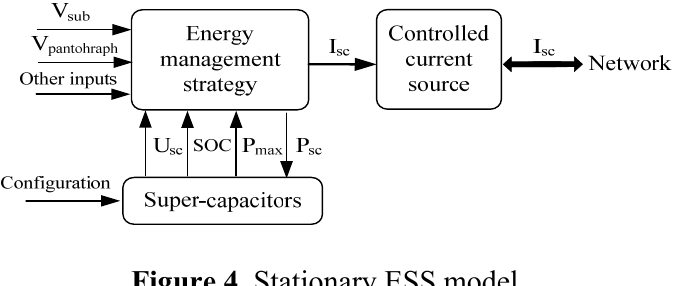
Figure 4. Stationary ESS